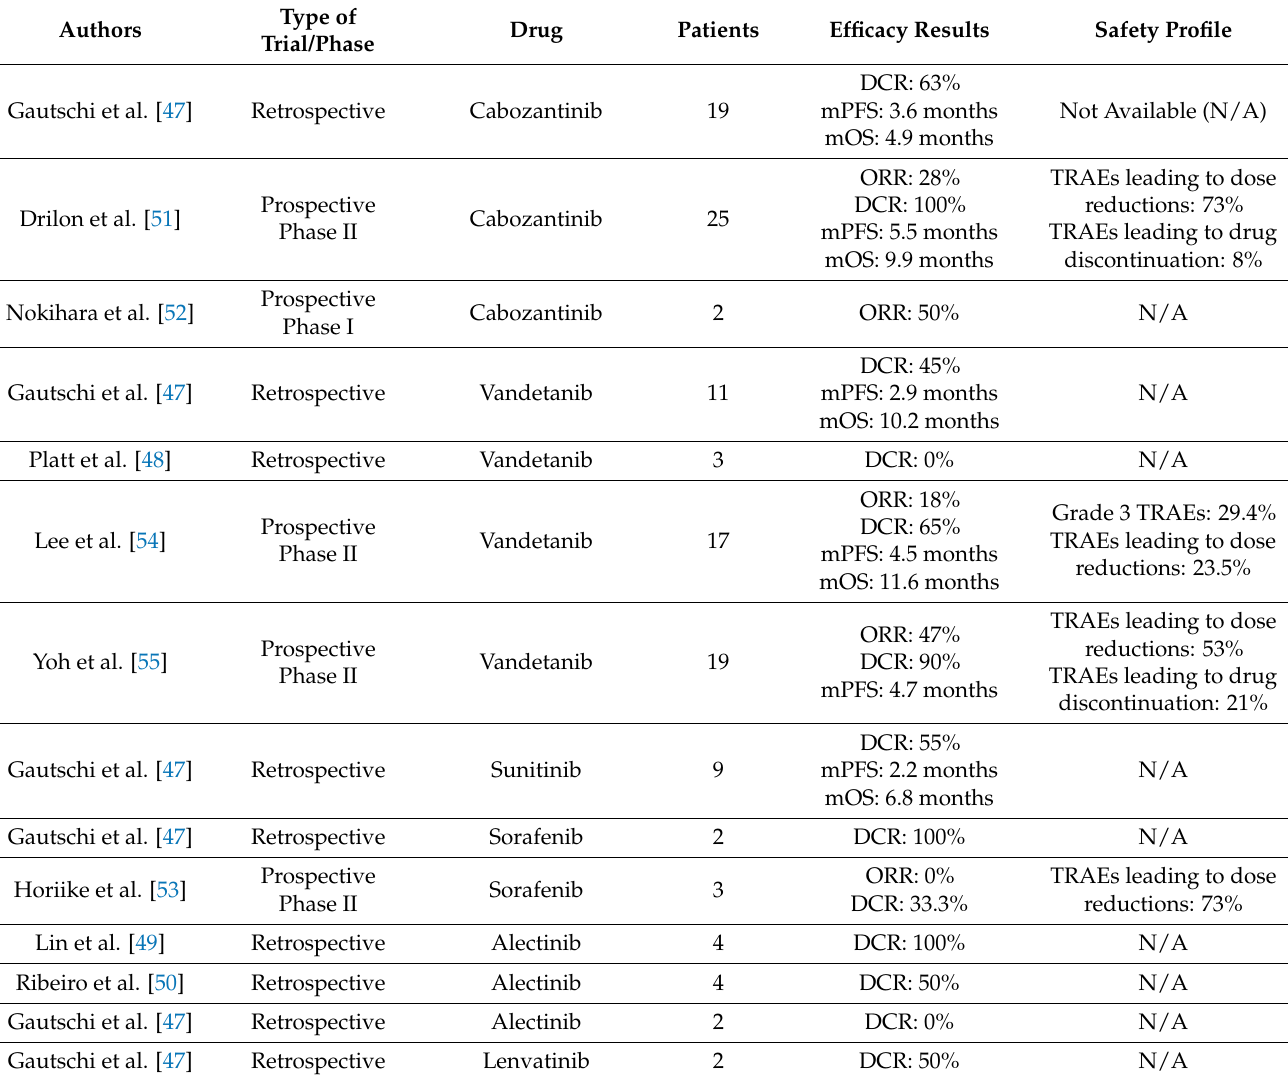
Table 1. Data coming from retrospective and prospective trials involving MKIs for the treatment of advanced RET+ NSCLC